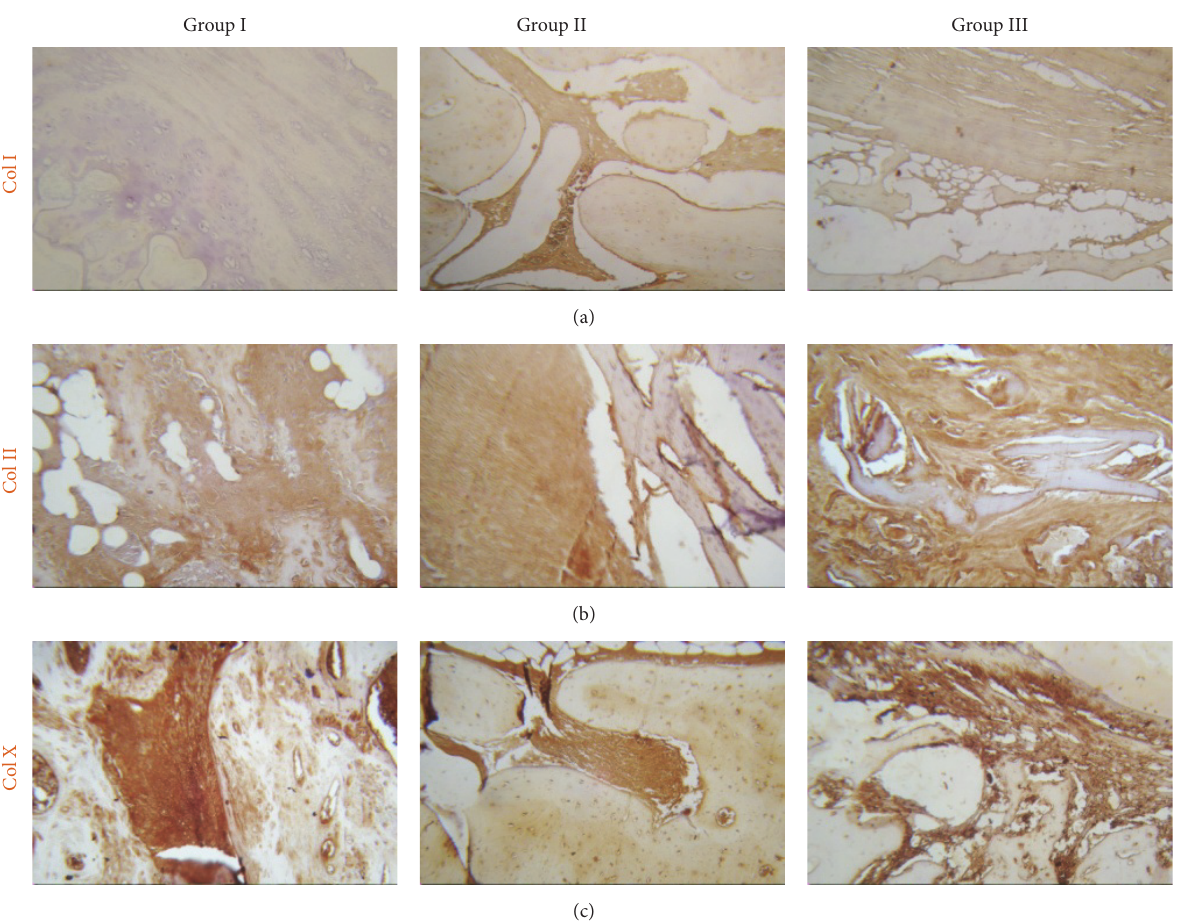
Figure 6: Postmortem IHC. (a) IHC for collagen I; (b) IHC for collagen II and (c) IHC for collagen X. Micrographs with 10x